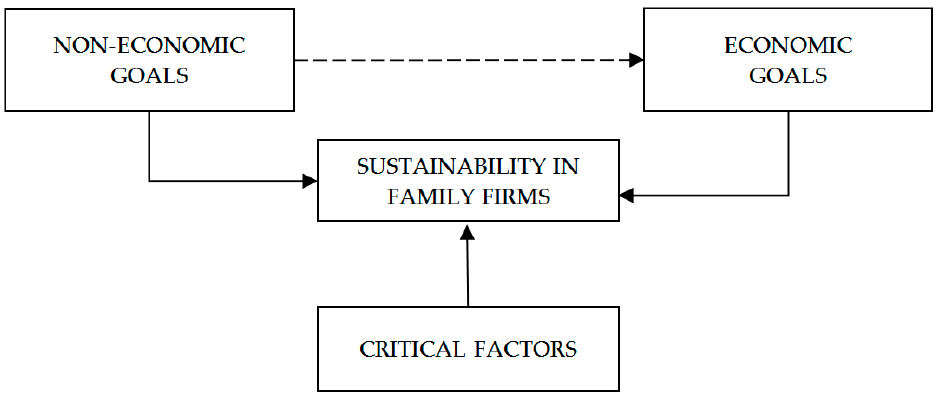
Figure 5. Structure research related to family firms y sustainability. Source: development by the authors.